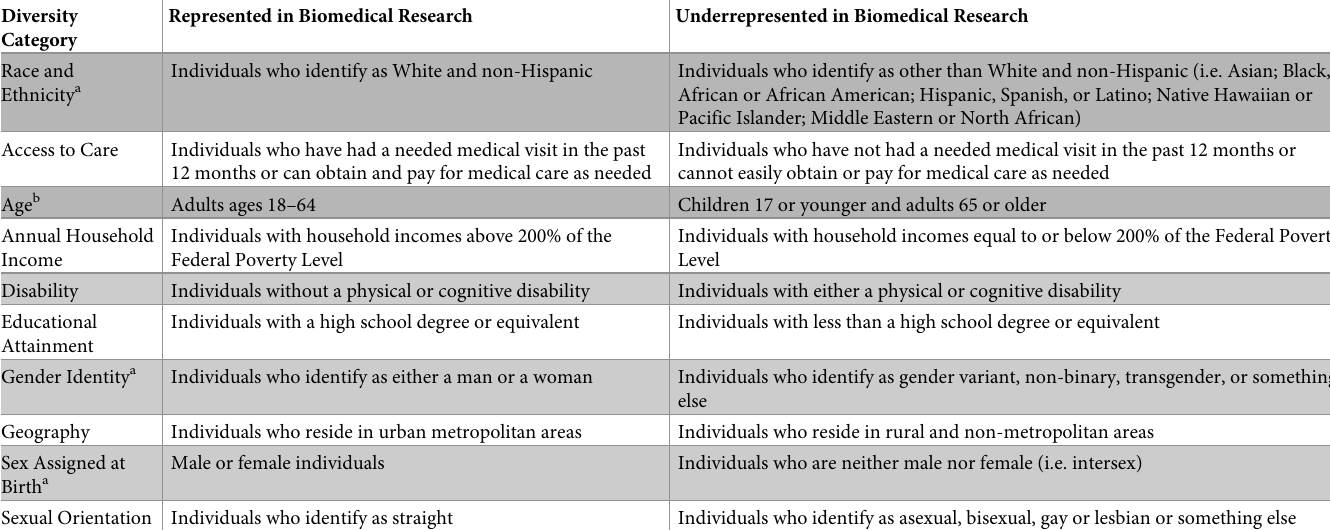
Table 1. The All of Us Guide for diversity and